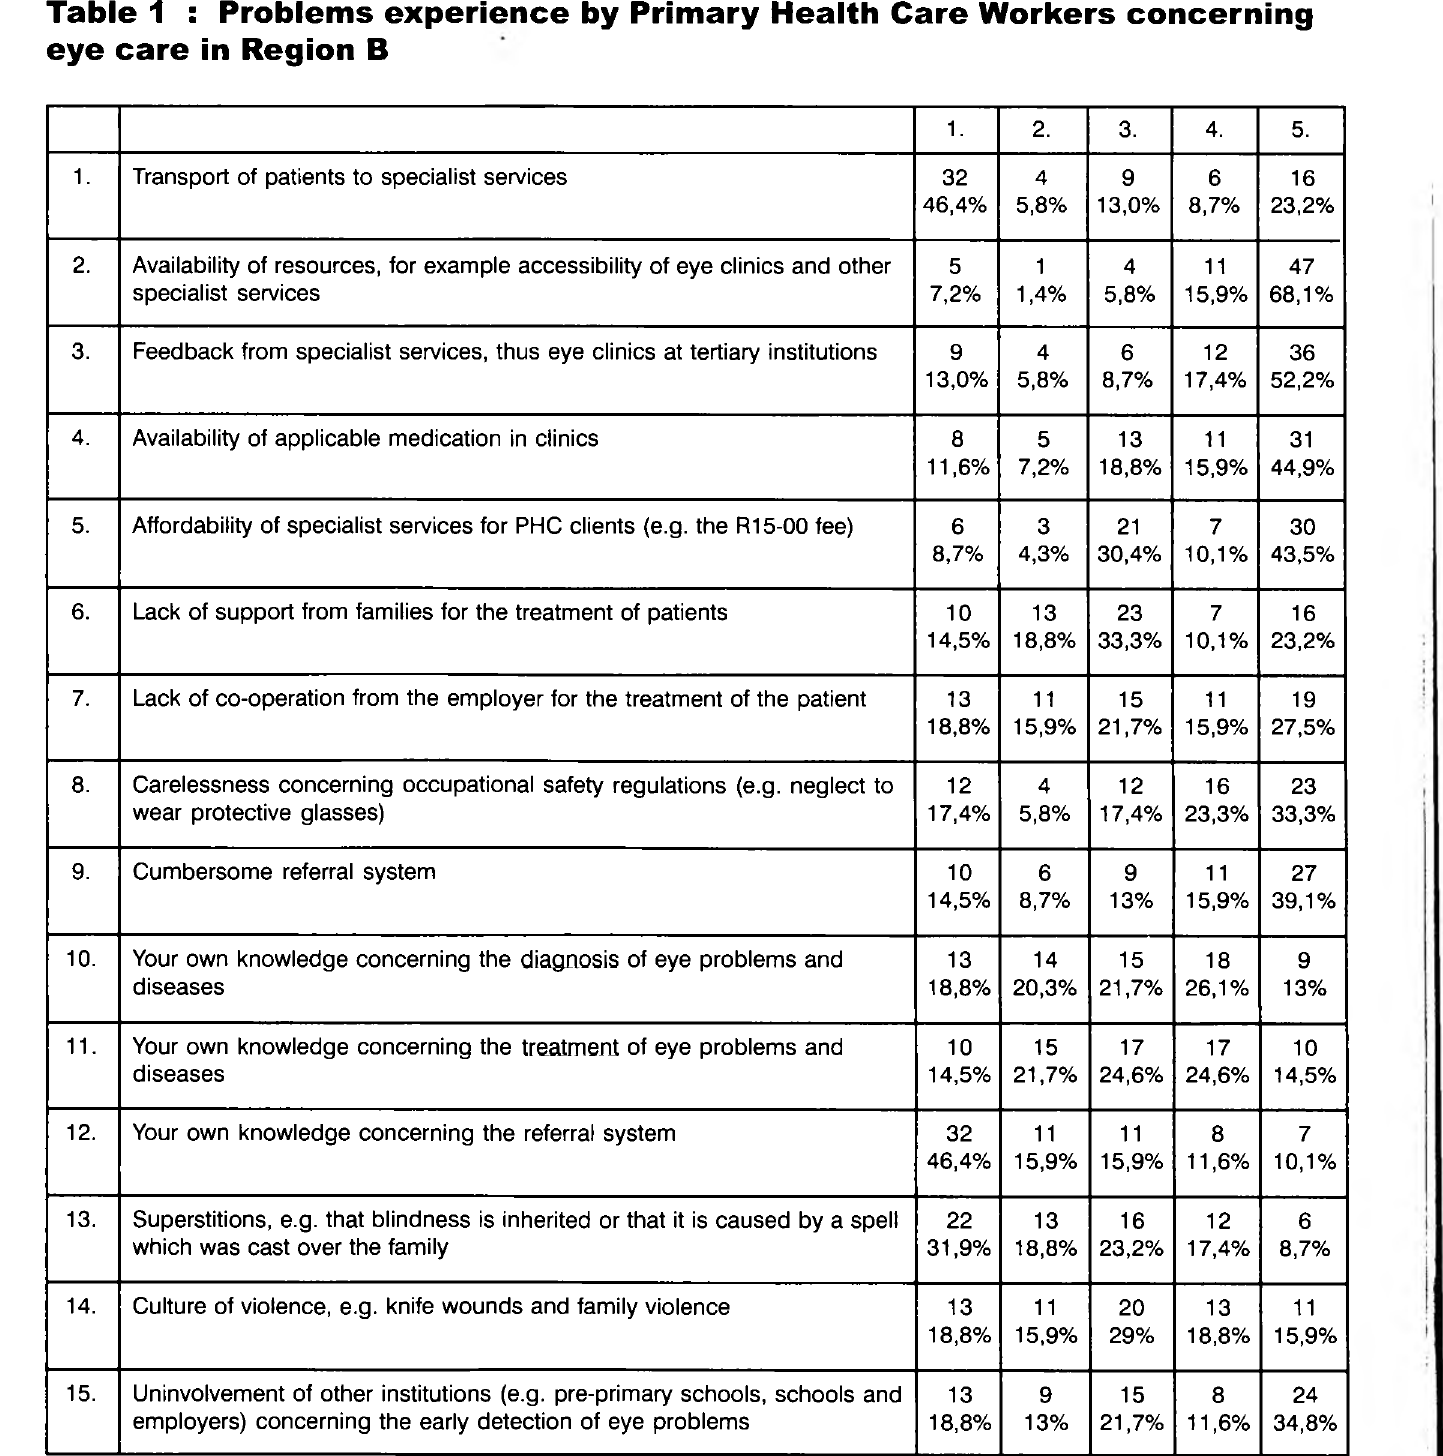
Table 1 : Problems experience by Prim ary Health Care W orkers concerning eye care in Region